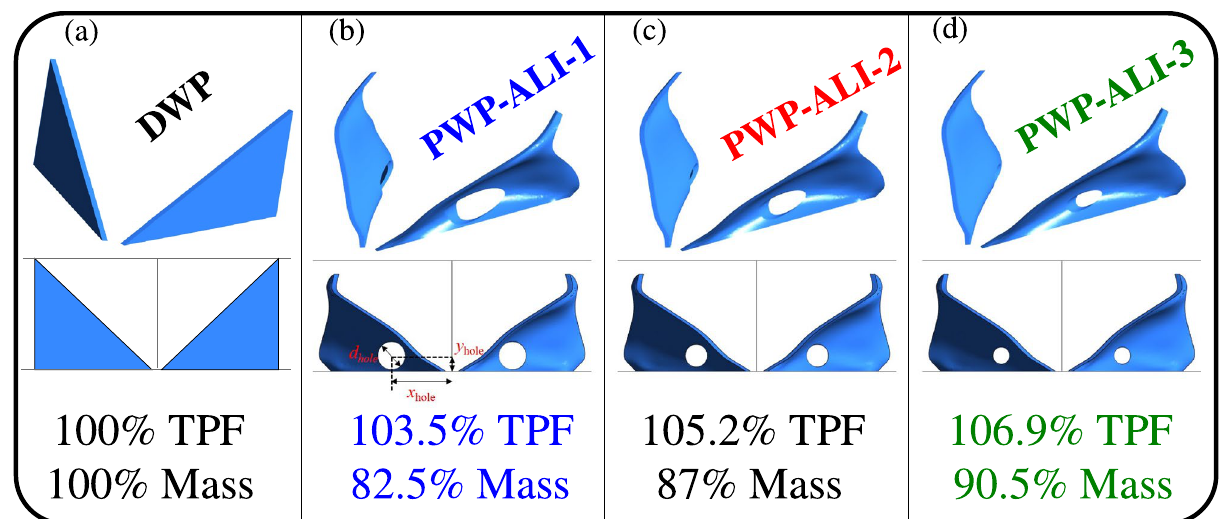
Figure 3. Optimization results for the TPF values versus mass reduction of the three optimal perforated PWP RVG designs, compared with the reference DWP RVG design that has 100% Mass and 100% TPF with TPF = 1.16 . According to the DWP reference design, an empty channel will have only 84% TPF with TPF = 1 . PWP were perforated with different hole diameters d hole such that: ( b ) d hole = 5 mm , ( c ) d hole = 4 mm , ( d ) d hole = 3 mm . The position of the hole is: x hole = 11 mm and y hole = 2.8 mm